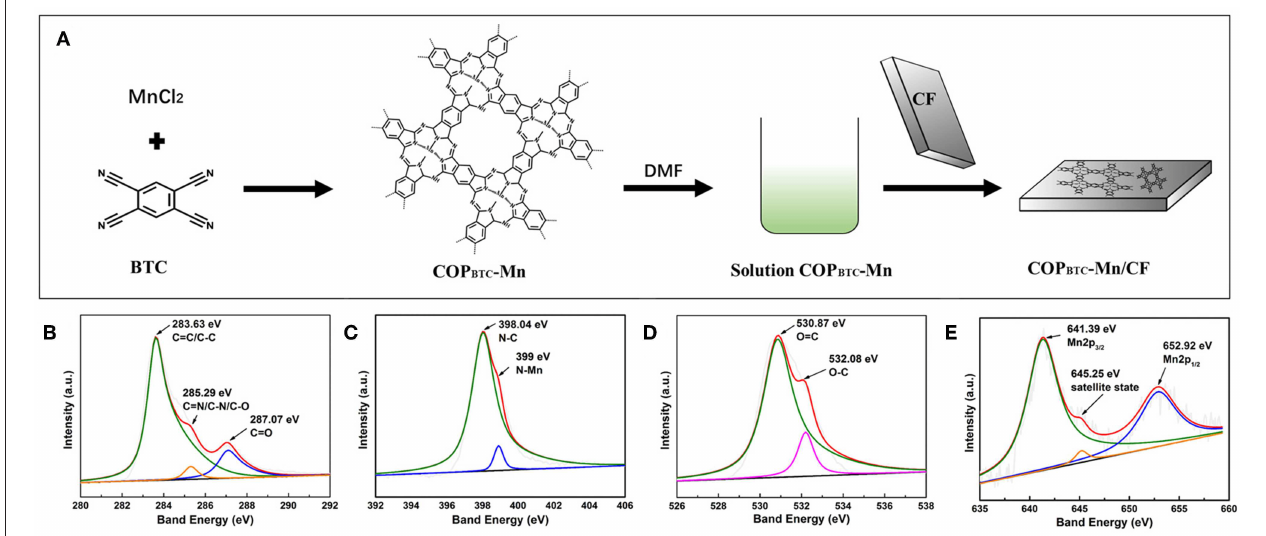
FIGURE 1 | (A) Schematic illustration of the overall synthetic process of COP BTC -Mn and COP BTC -Mn/CF. The COP BTC -Mn XPS of (B) C, (C) N, (D) O, (E) Mn, respectively.